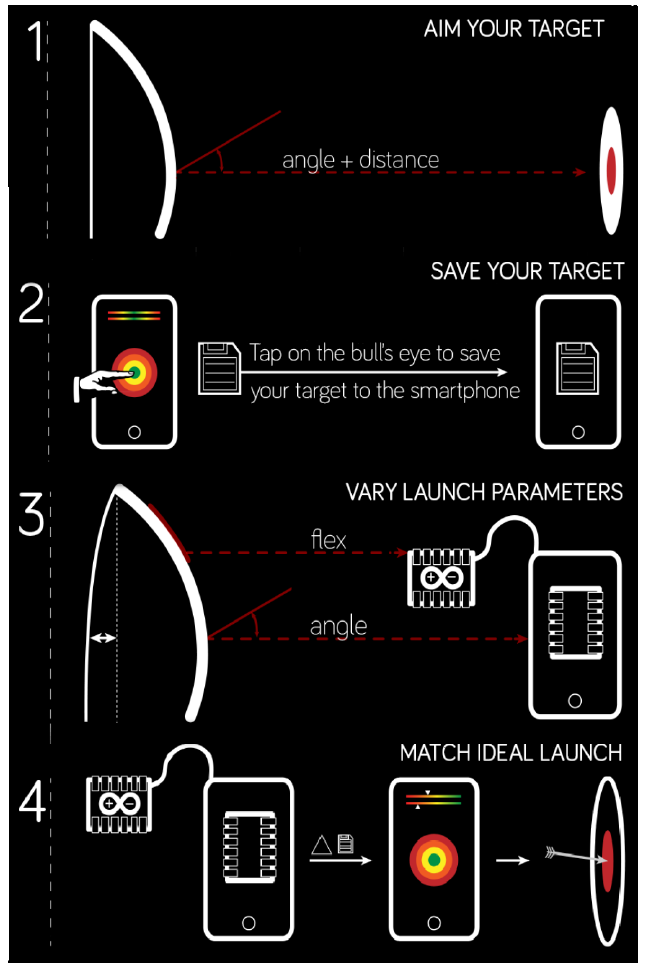
Figure 13. 4-step process of the interactive archery